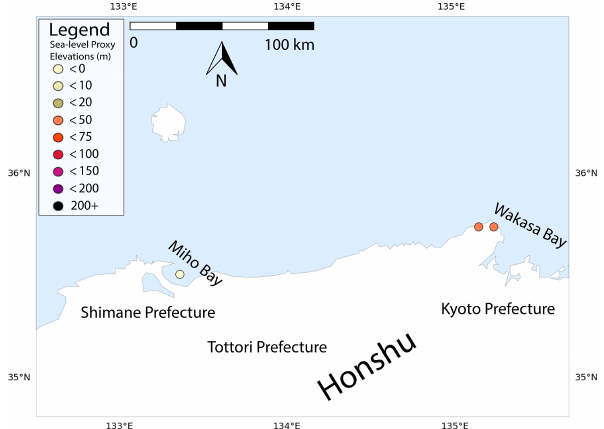
Figure 9. Sea-level elevation proxies along the Japan Sea (Kansai and Chugoku). Sea-level indicators (circles) with elevation range indicated by color (see legend).